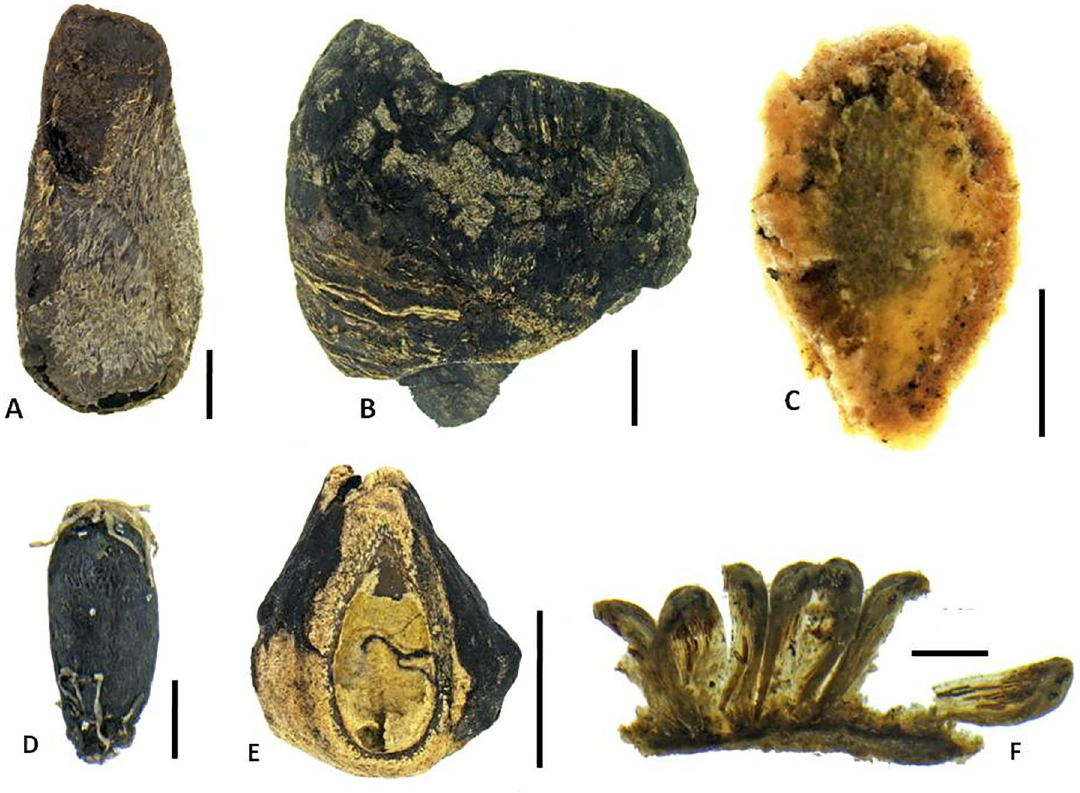
Fig 8. Representative plant macrofossils (seeds unless otherwise stated). A. Morinda citrifolia ; B. Pritchardia -type (outer surface); C. Curcubitaceae indet.; D. Pterophylla cf. marquesana ; E. Premna serratifolia (endocarp showing seed chamber); F. Angiopteris marchionica (sorus with sporangia). Scale bars: A, B, C, E, 2 mm; D, F, 0.25 mm. (Photos by N. Porch).